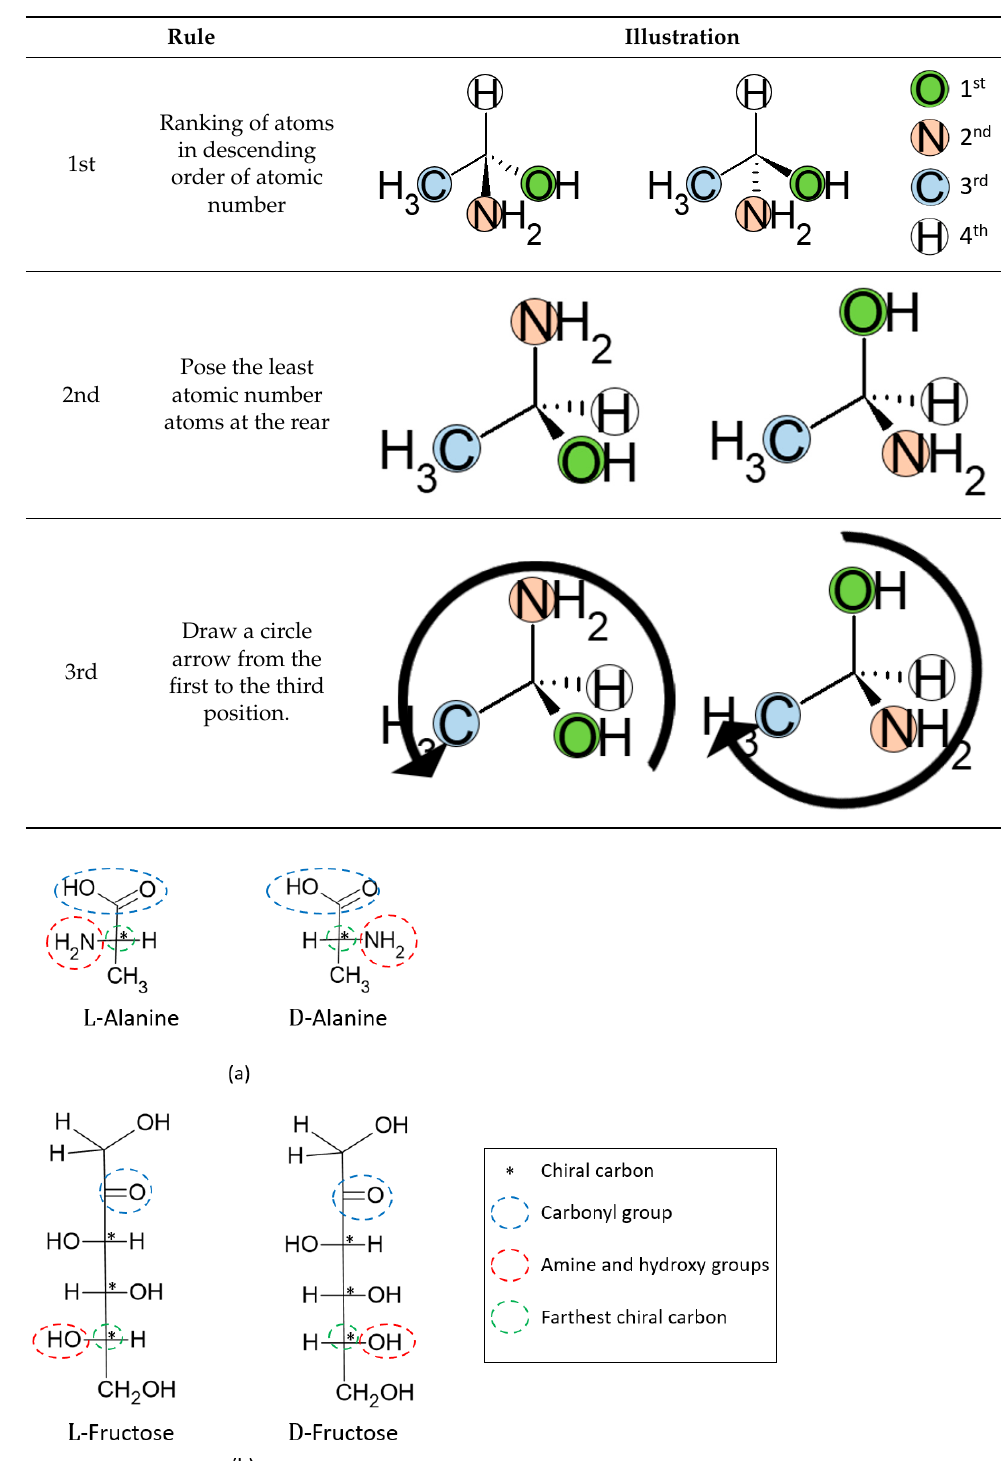
Figure 5. ( a ) Amino acids 𝐿 and 𝐷 -Alanine and ( b ) monosaccharides 𝐿 and 𝐷 -Fructose. Table 2. Rules for enantiomer nomenclature. Table 2. Rules for enantiomer nomenclature.